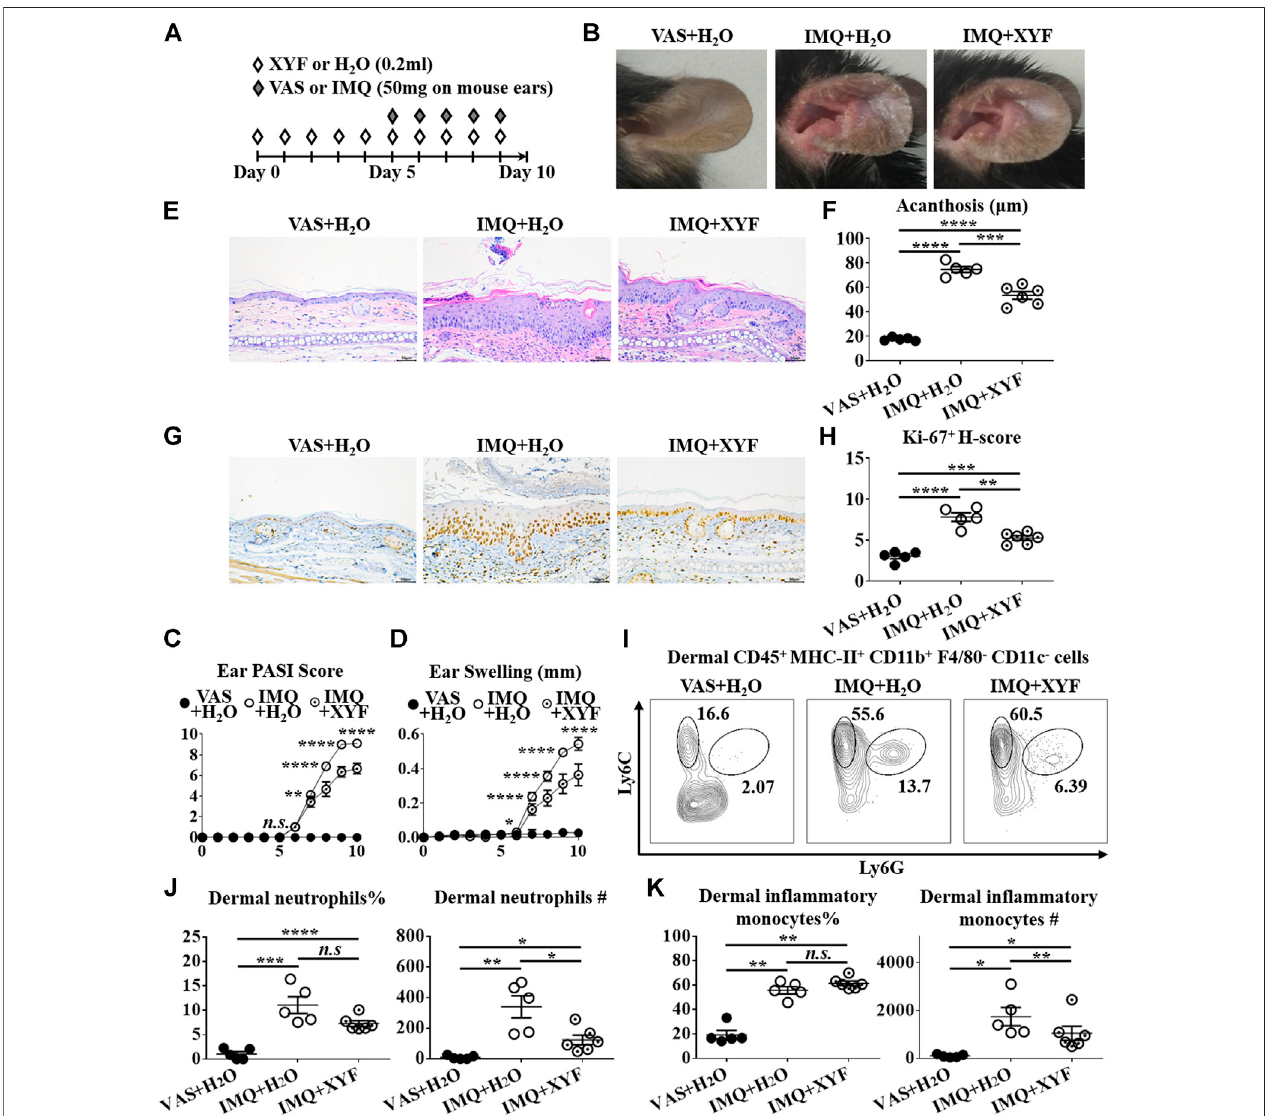
FIGURE 4 | Xiao-Yin-Fang lessened imiquimod-induced psoriasis-like dermatitis on mouse ears. (A) Schematic of the experimental procedures. Mice were given XYForH 2 Obygavagetwicedailyfromday0today9,andreceivedIMQorVASapplicationonmouseearsonceadayfromday5today9 (B) Representativepicturesof mouse ear lesions. (C, D) Evaluation of PASI score (C) and skin swelling (D) of mouse ears ( n (cid:2) 27, three independent experiments) (E) H&E staining and calculated epidermal acanthosis (F) (x200; bar (cid:2) 50 μ m; n (cid:2) 18, three independent experiments). (G) Ki-67 staining and assessment of its H-score of epidermal fi elds (H) (x200; bar (cid:2) 50 μ m; n (cid:2) 18, three independent experiments). (I – K) Freshly isolated dermal cells were obtained and stained with anti-CD45, MHC-II, CD11b, F4/80, CD11c, Ly6C, and Ly6G antibodies, which were analyzed by fl ow cytometry. (I) Representative scatter plots of dermal neutrophils and in fl ammatory monocytes. The ratios and cell numbers of dermal neutrophils (J) and in fl ammatory monocytes (K) ( n (cid:2) 16, three independent experiments). The data were presented as mean ± s.e.m.